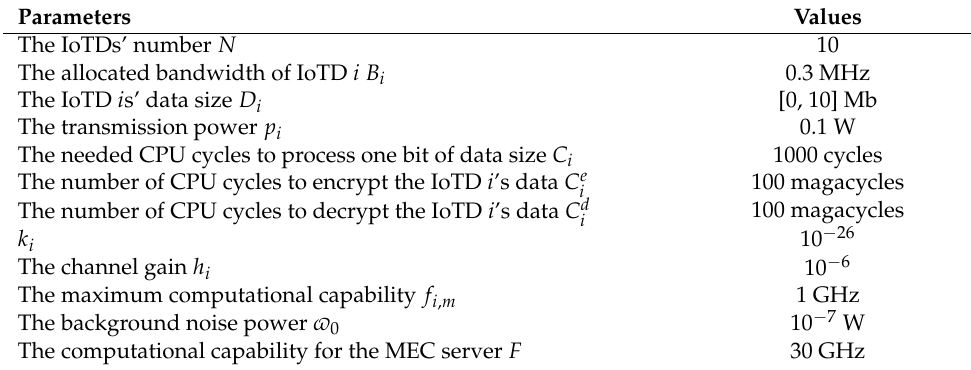
Table 2. Parameter values Settings.